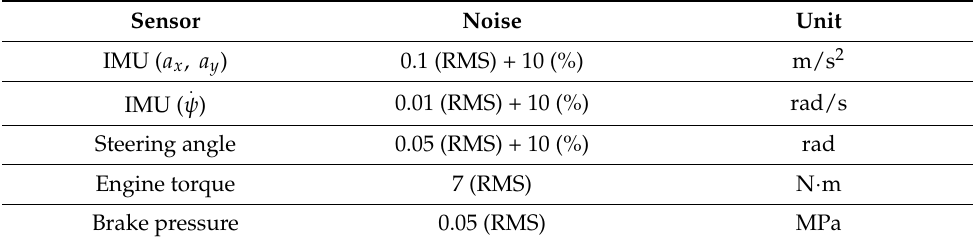
Table 5. Sensor configuration for simulation.